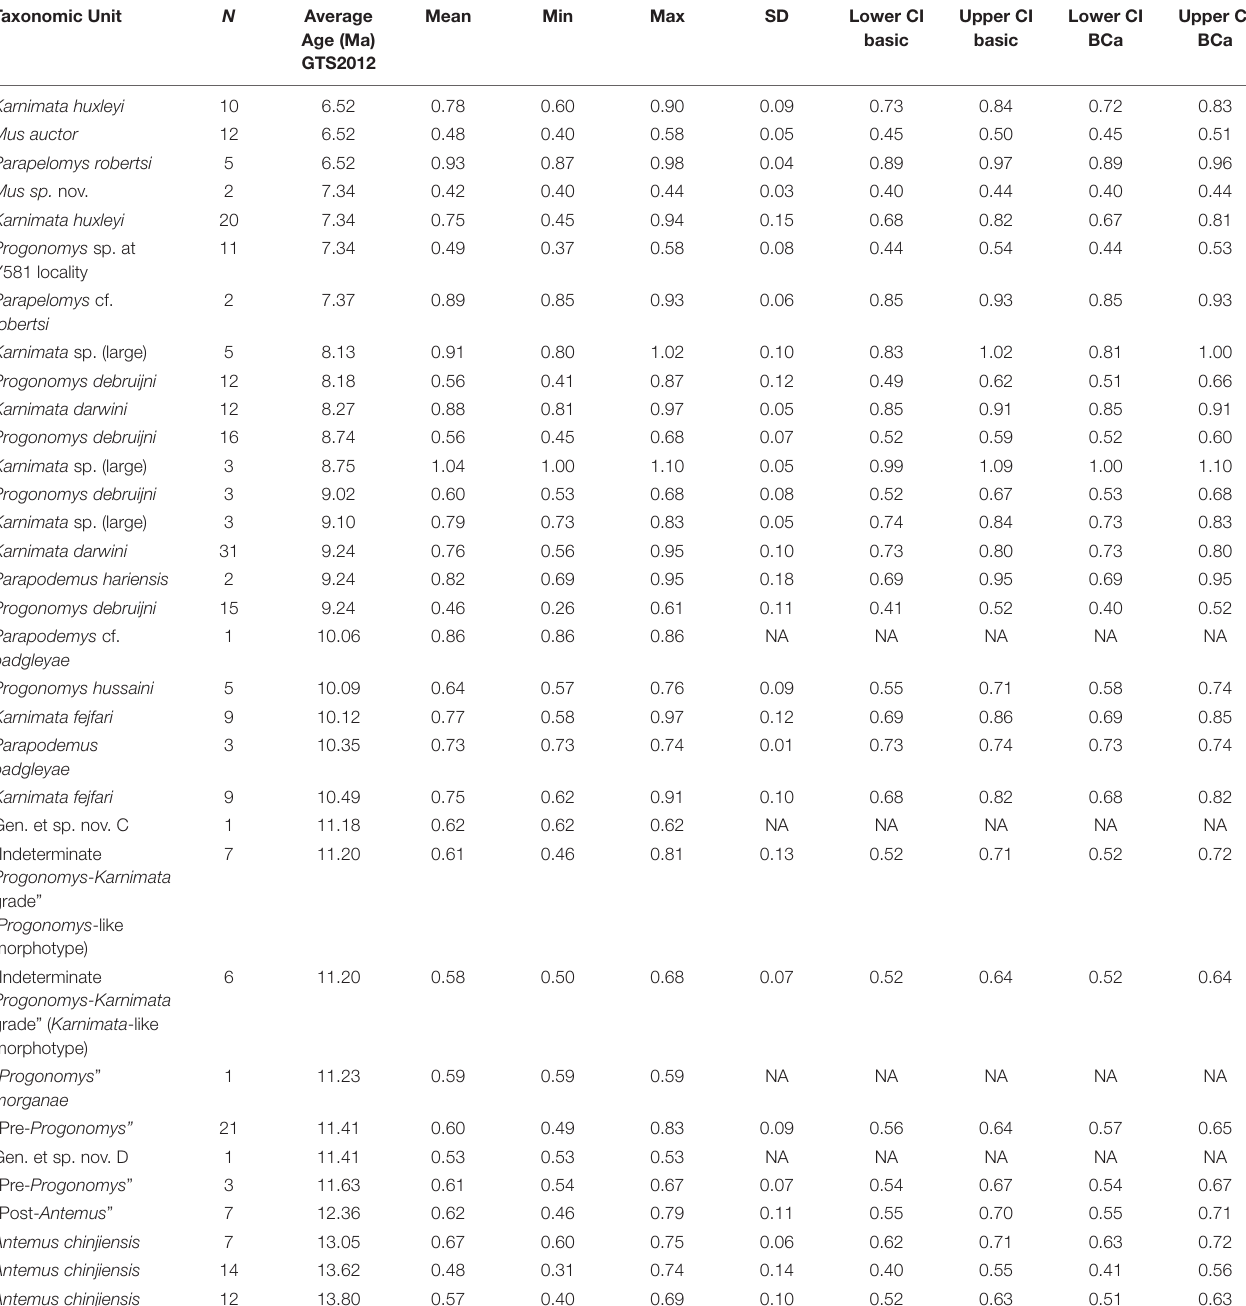
TABLE 2 | Summary statistics for anterostyle ratio in Siwalik murine rodents, corresponding to Figure 3A . Taxonomic Unit